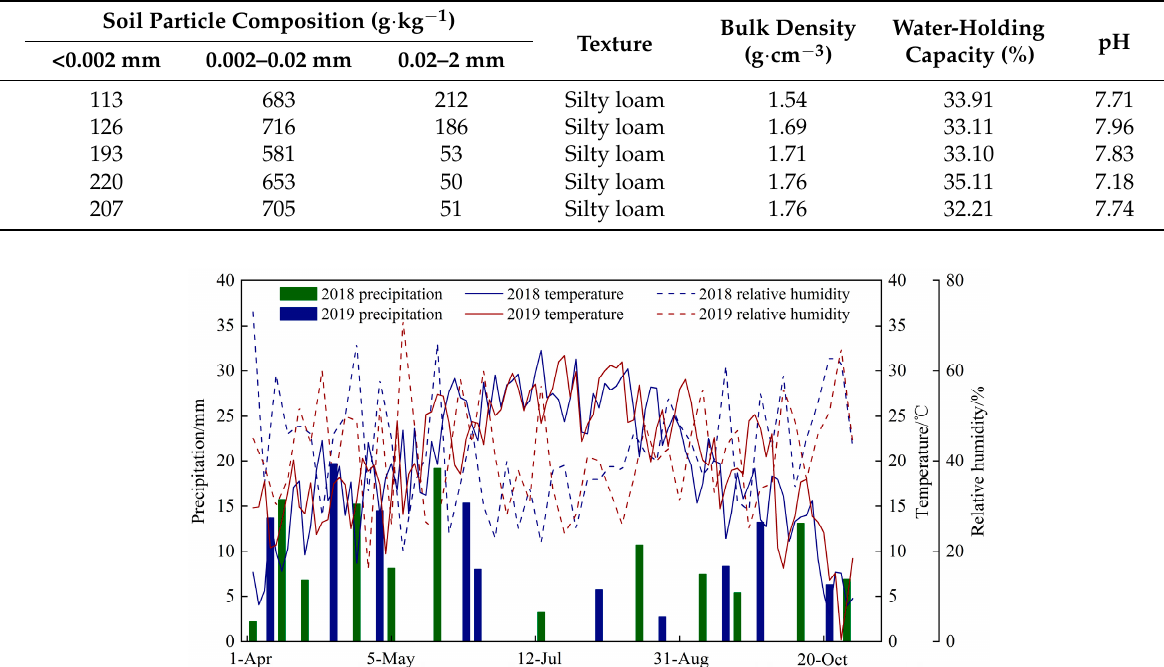
Figure 1. The experimental station’s location. Table 1. Physical and chemical properties of soil at the test site.